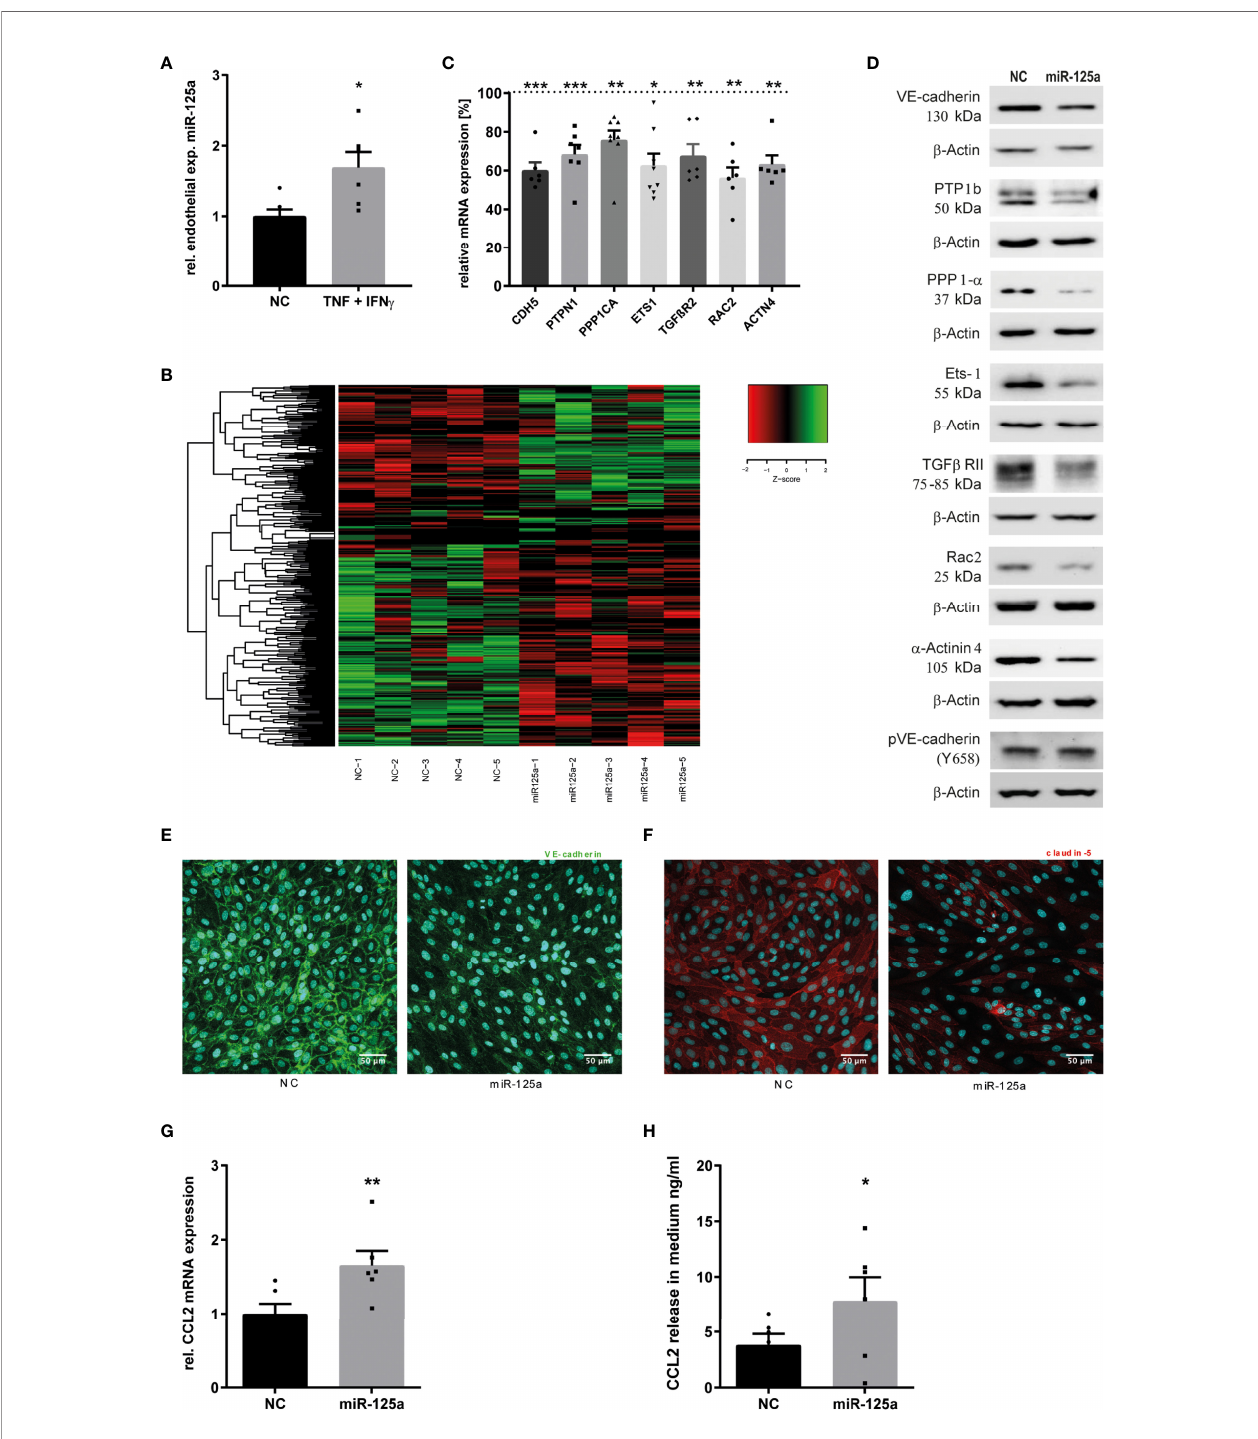
FIGURE 1 | MiR-125a expression upon in fl ammatory stimulation of HUVEC and its effect on endothelial transcriptome. (A) Endothelial expression of miR-125a after cytokine treatment with 25ng/ml TNF and 50 ng/ml IFN- g for 4 hours (n=6, p<0.05). (B) Clustered heatmap of z-scaled expressions of signi fi cantly differentially expressed genes in HUVEC transfected with either miR-125a or scrambled control (NC) (Whole transcriptome RNAseq, n=5). Green color indicates enhanced expression, reduced expression is indicated in red color. (C, D) mRNA ( qRT-PCR) and protein (SDS-PAGE) expression of differentially regulated genes extracted from RNAseq data (n=6-8, **p<0.01 ***p<0.001). (E, F) Immuno fl uorescent staining of VE-Cadherin and Claudin-5 in endothelial cells transfected with miR-125a or scrambled control (NC). One exemplary picture of three independent experiments is shown. (G, H) expression levels of CCL2 mRNA and protein in HUVEC and cell culture supernatant, respectively (n=6; **p<0.01,